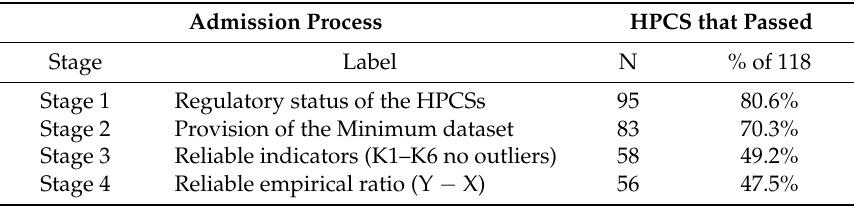
Figure 3. Regression plot and confidence interval of individual predictions (Stage 4). Labeled as HPCS IDs. Table 3. Summary of the admission Process of the 118 registered Table 4. Main activity indicators and outcome (N = 56 HPCSs of the Best Practice Panel).